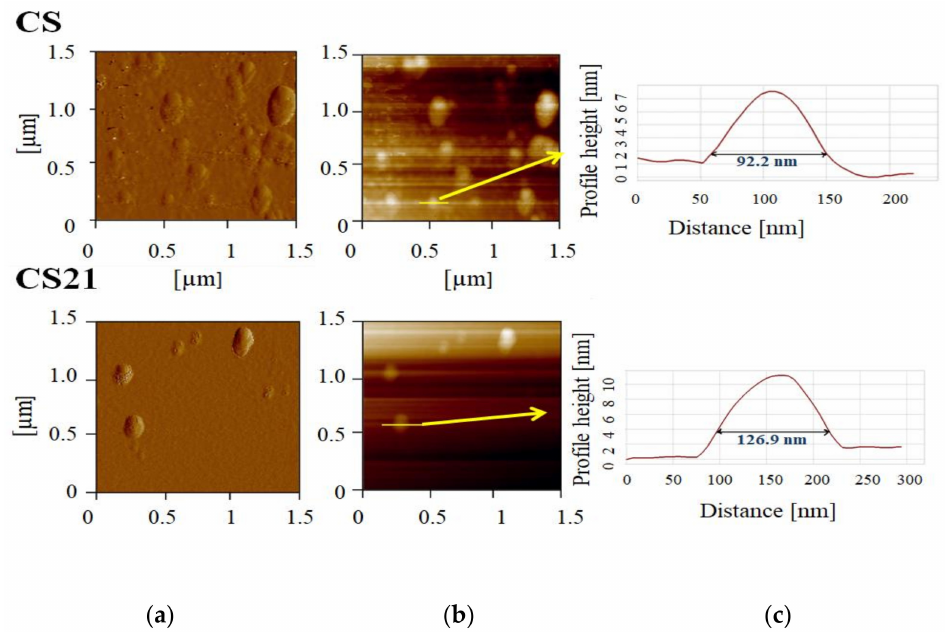
Figure 5. AFM images of curcumin-loaded nanoemulsions with soybean oil, non-PEGylated (CS), and PEGylated containing 0.1% of PEG2000-DSPE (CS21): ( a ) error signal of 1.5 × 1.5 µ m 2 area of the sample; ( b ) 2D topography; ( c ) height profiles of selected nanoemulsion